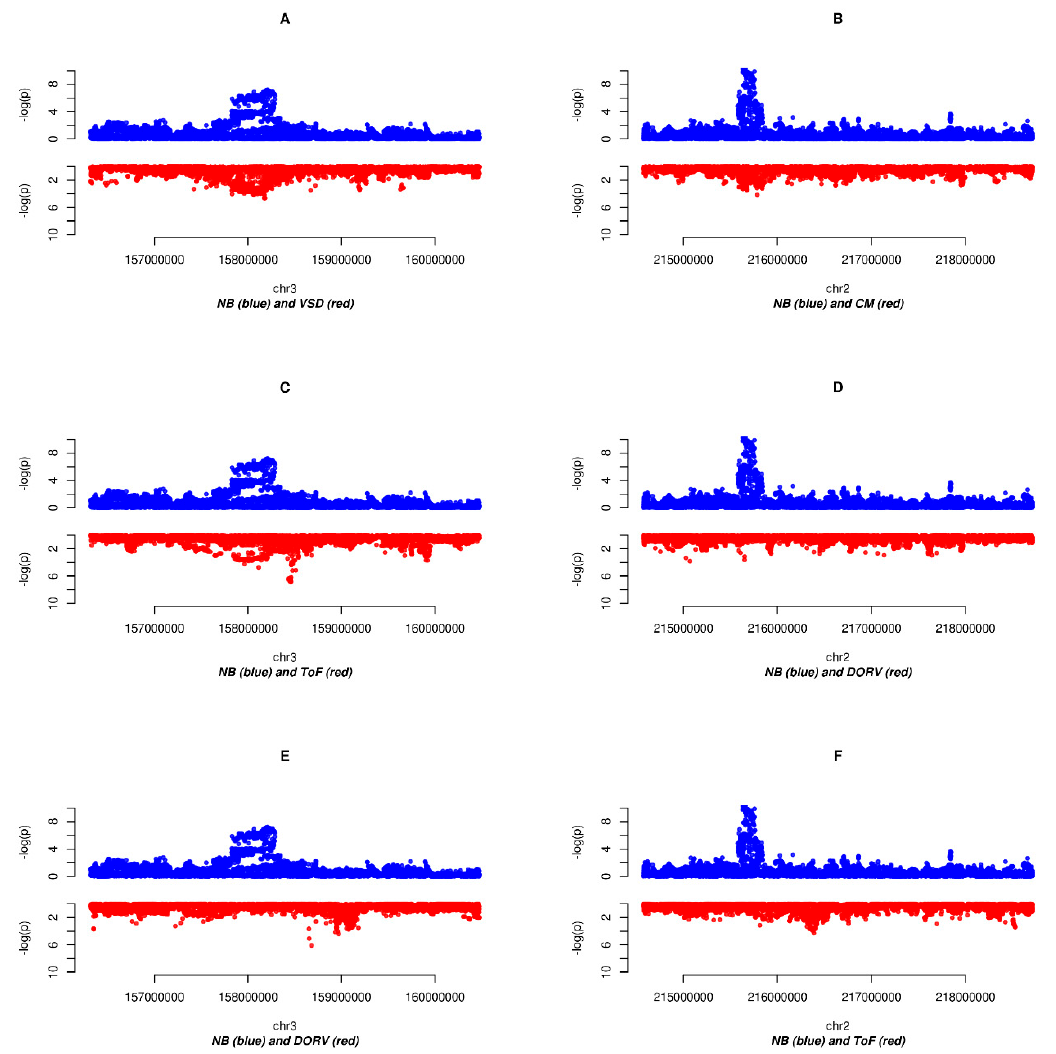
Figure 2 . Regional association plots of significant loci described in text. In blue is NB, in red are di ff erent subtypes of CHD. ( A ) NB and VSD at 3q25.32, ( B ) NB and CM at 2q35, ( C ) NB and ToF at 3q25.32, ( D ) NB and DORV at 2q35, ( E ) NB and DORV at 3q25.32, ( F ) NB and ToF at 2q35.